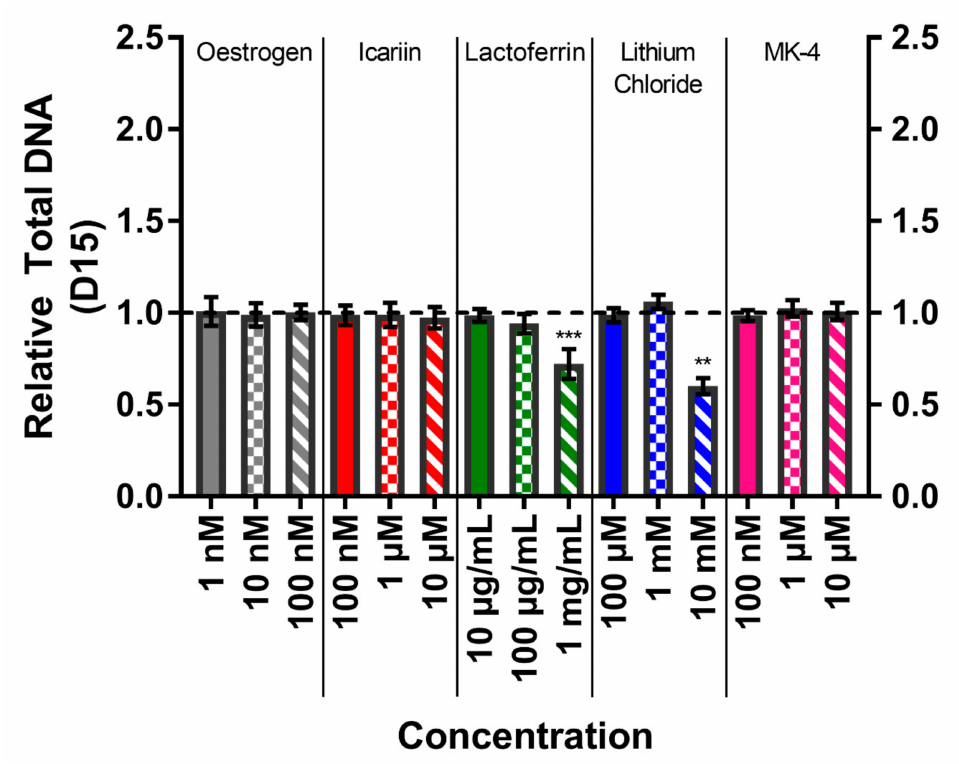
Figure 4. The e ff ect of each compound and concentration on the total DNA per well at day 15, normalised to their respective vehicle control (horizontal dashed line). The treatment with lactoferrin (1 mg / mL) and lithium chloride (10 mM) significantly lowered the total DNA (p < 0.001 & P < 0.01, respectively). No other condition significantly deviated from the vehicle control. (n =